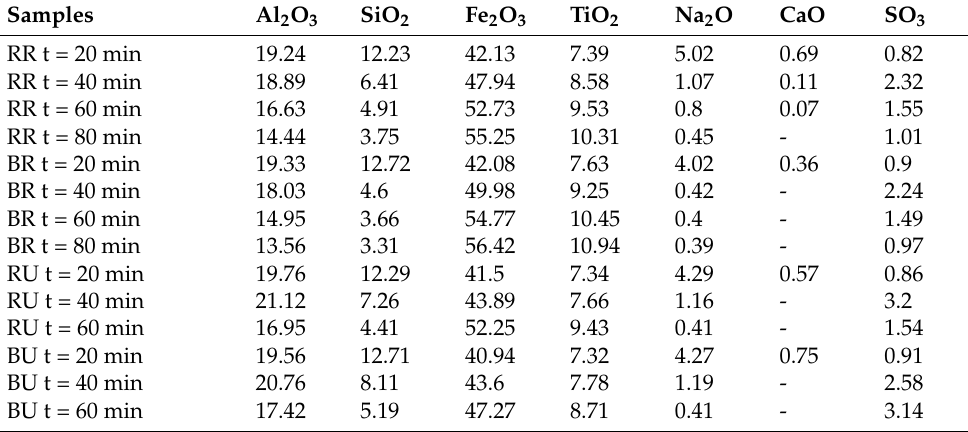
Table 3. XRF results of the compositions of red mud in the desulfurization process (wt.%) (raw red mud desulfurization (RR), ball mill red mud desulfurization (BR), raw red mud desulfurization under an ultrasonic external field (RU), ball mill red mud desulfurization under ultrasonic external field